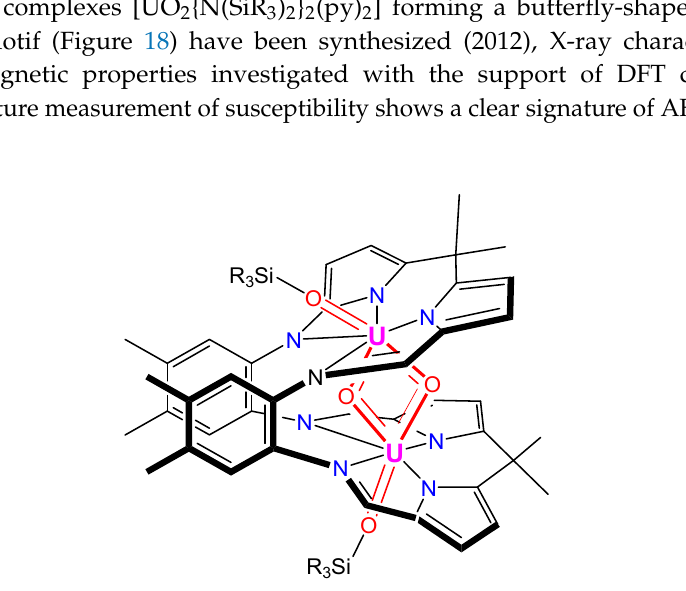
2 {N(SiR 3 ) 2 } 2 (py) 2 ] complex